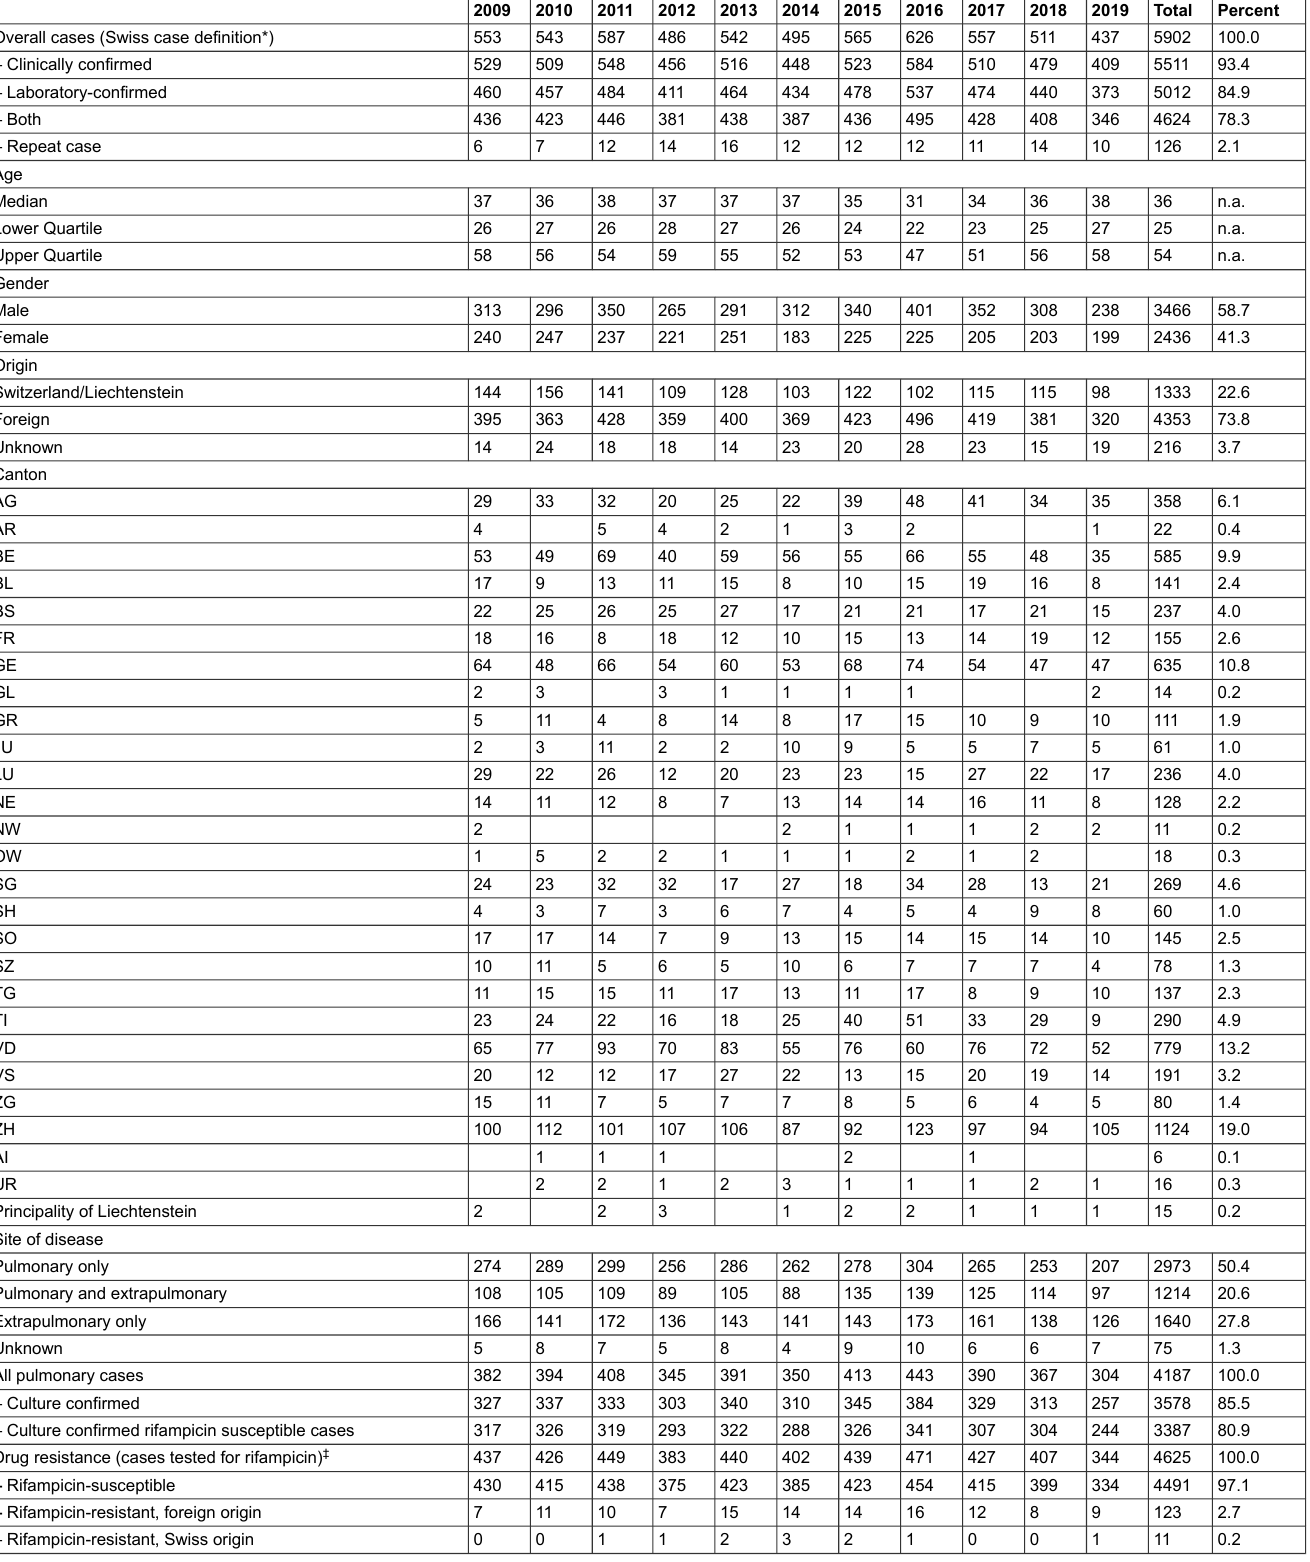
Table 1: Summary of tuberculosis cases in Switzerland and Liechtenstein,